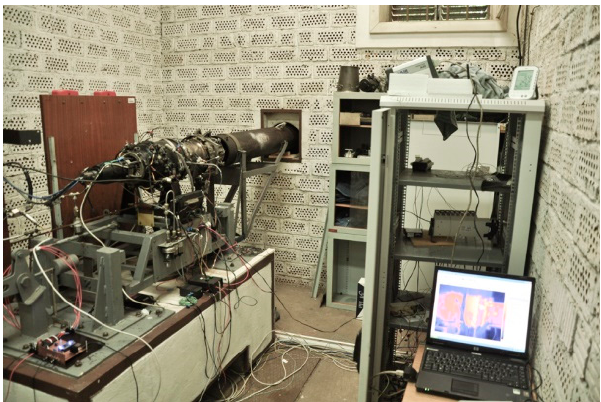
Figure 11. The arrangement of the FLIR Thermovision A40 thermal imaging camera in the laboratory.